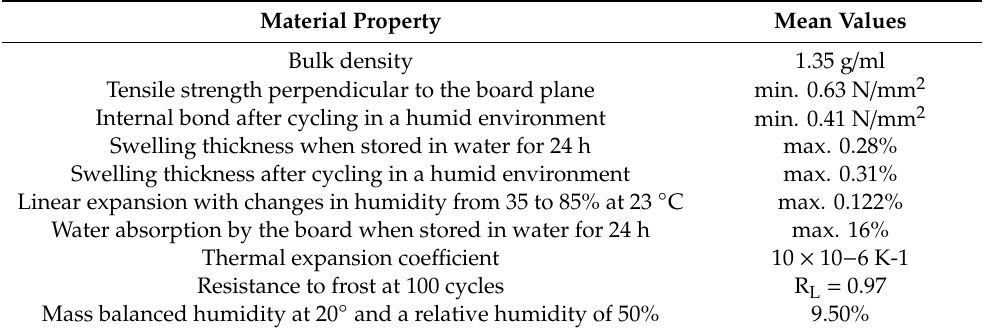
Table 1. Basic physical and mechanical properties of the façade cladding board